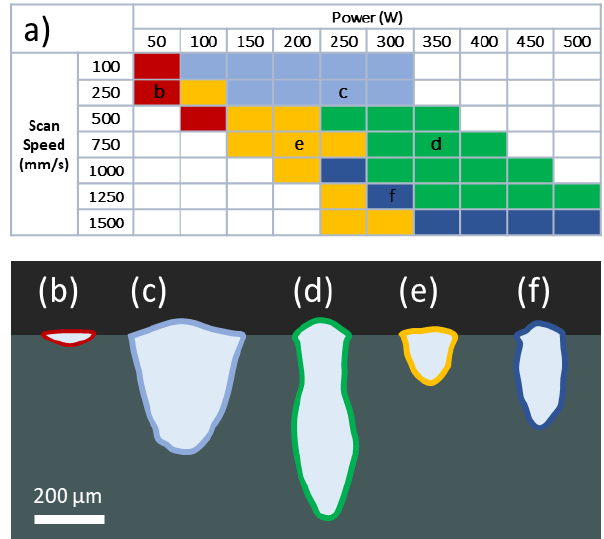
Figure 6. ( a ) Classification of melt-track geometries revealing the shape regimes. ( b ) Small, shallow melt pool, ( c ) wide and deep melt pool, ( d ) unusual bowling-pin-shaped melt pool, ( e ) the melt-pool regime most suitable for printing, and ( f ) slightly deeper and thin melt pool.